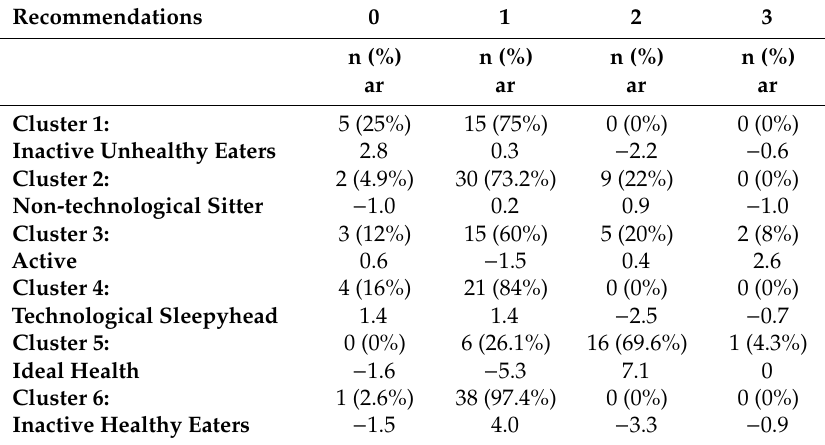
Association between resulting clusters with recommendations for the 24-hour movement